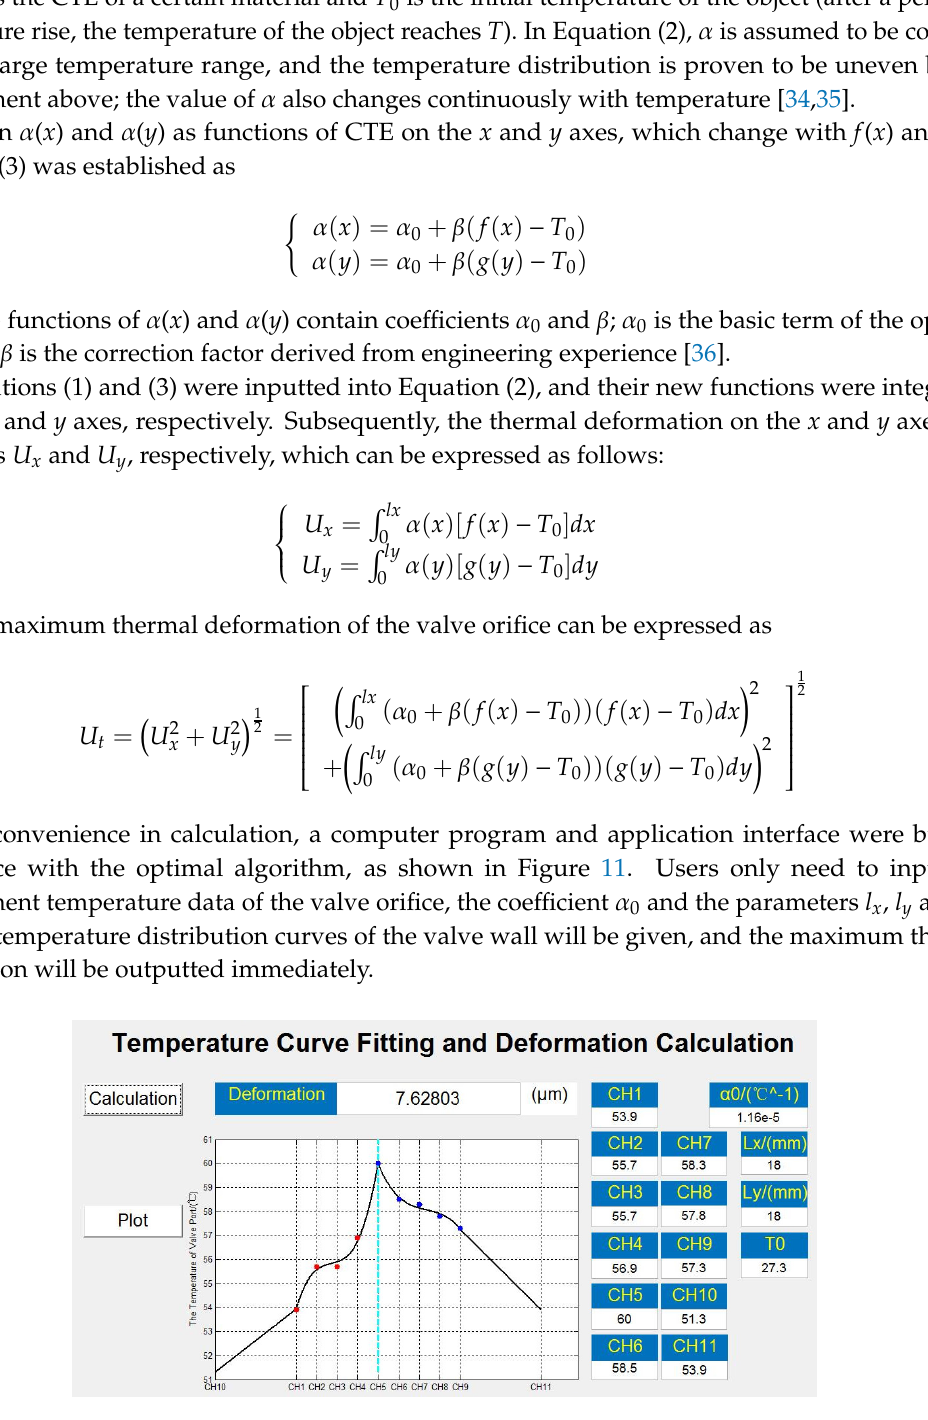
Figure 11. Application interface of the M-OA method ( x = 1 mm, p in = 2 MPa, t = 105 min,